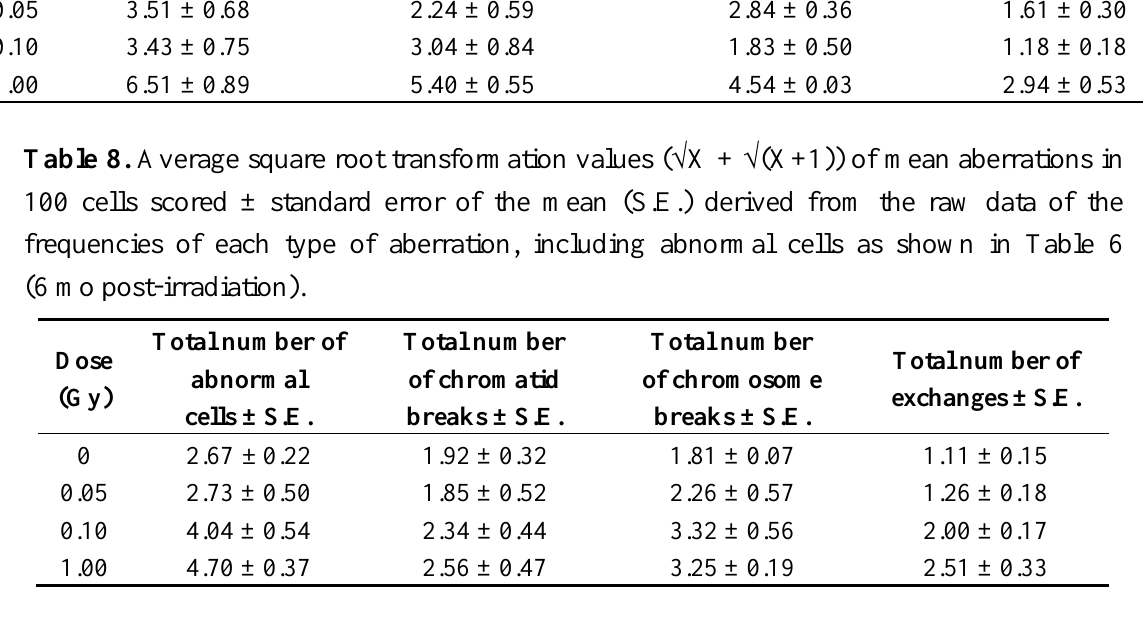
Figure 5. Frequencies of each type of aberration per 100 cells scored (±S.E.) detected in BM cells collected from SCID/J mice at 6 mo post-irradiation. Significant differences in the frequencies of each type of CA in BM cells of exposed mice, as compared to the frequencies detected in non-irradiated sham controls are shown at “ 